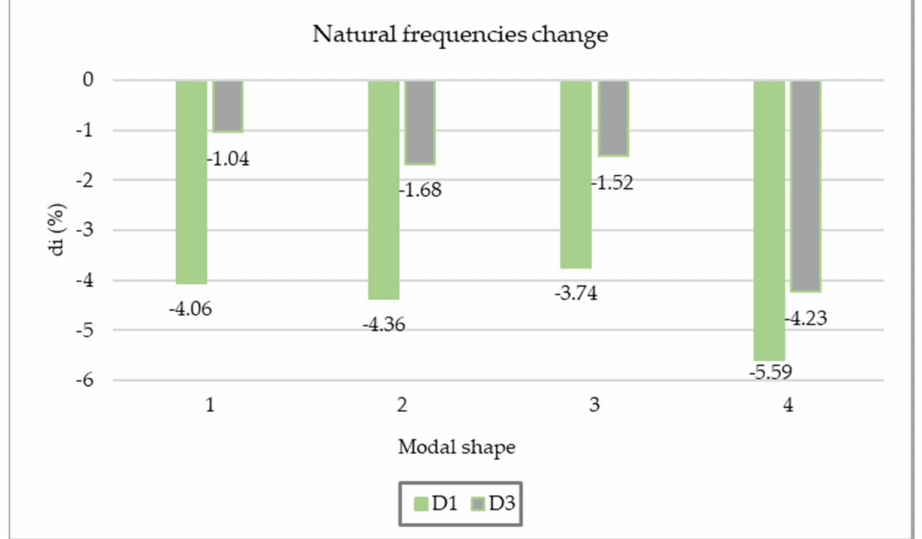
Figure 6. Representation of the change in the values of natural frequencies on beams D1 (steel surface loss 7.77%, maximum crack width 5.0 mm) and D3 (steel surface loss 7.65%, maximum crack width 1.0 mm) (author’s processing based on [53]).